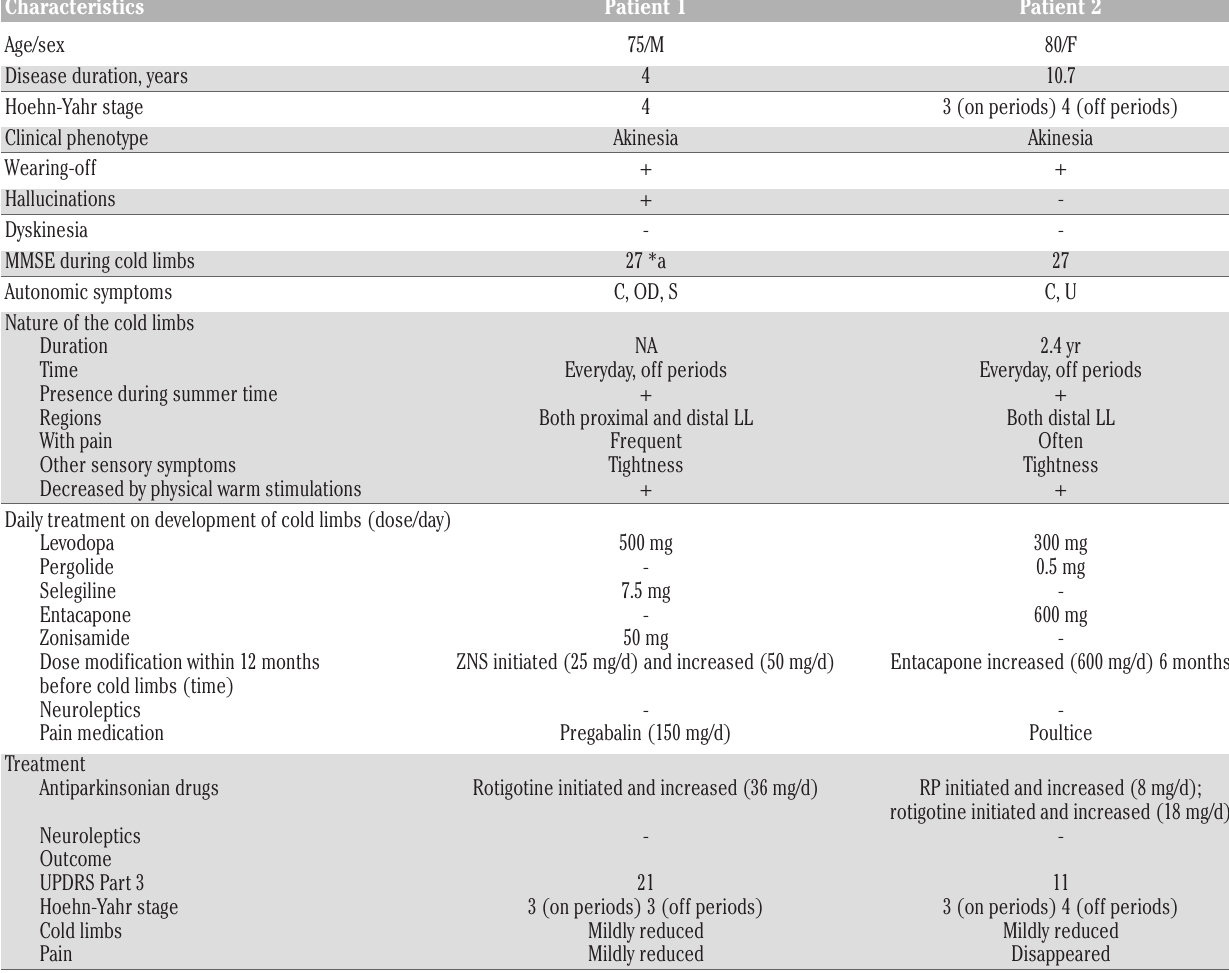
Table 1. Clinical characteristics of two patients with Parkinson’s disease who had severe coldness of the lower limbs.